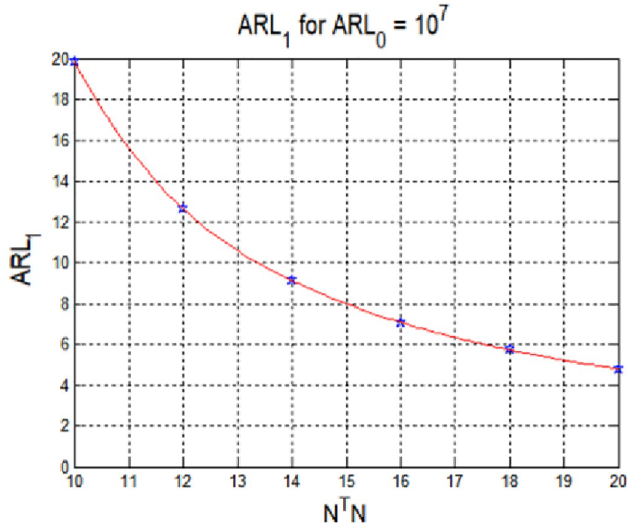
Fig 1. Threshold for spoofing signal detection according to the average run